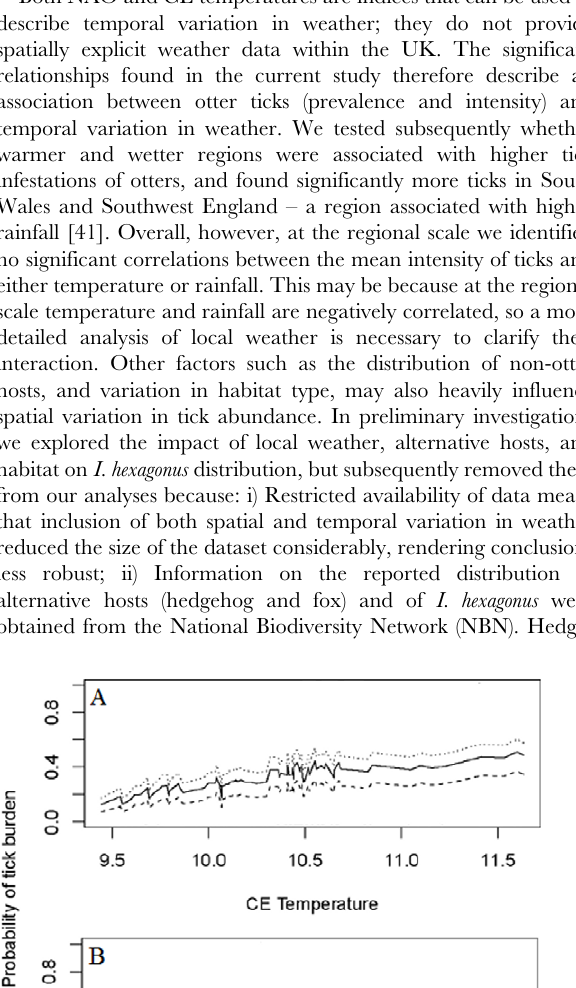
Figure 1. Tick distributions across the UK. Distribution of Ixodes hexagonus infested (dark circles) and uninfested (clear circles) otters in England and Wales. Meteorologically distinct regions (East and Northeast England, East Anglia, Southeast England and Central South, Northwest England and North Wales, South Wales and Southwest England, and Midlands) defined by the Meteorological Office UK Climate Impacts Programme (data available online).